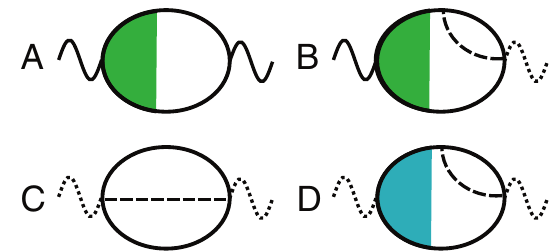
Fig. 2 The four diagrams which contribute to the conductivity. Bold lines are renormalized electron propagators, dashed lines are phonon propagators, and the full and dashed wiggly lines correspond to J 0 and J 1 , respectively. The green and blue areas represent the renormalized J 0 and J 1 vertex functions,